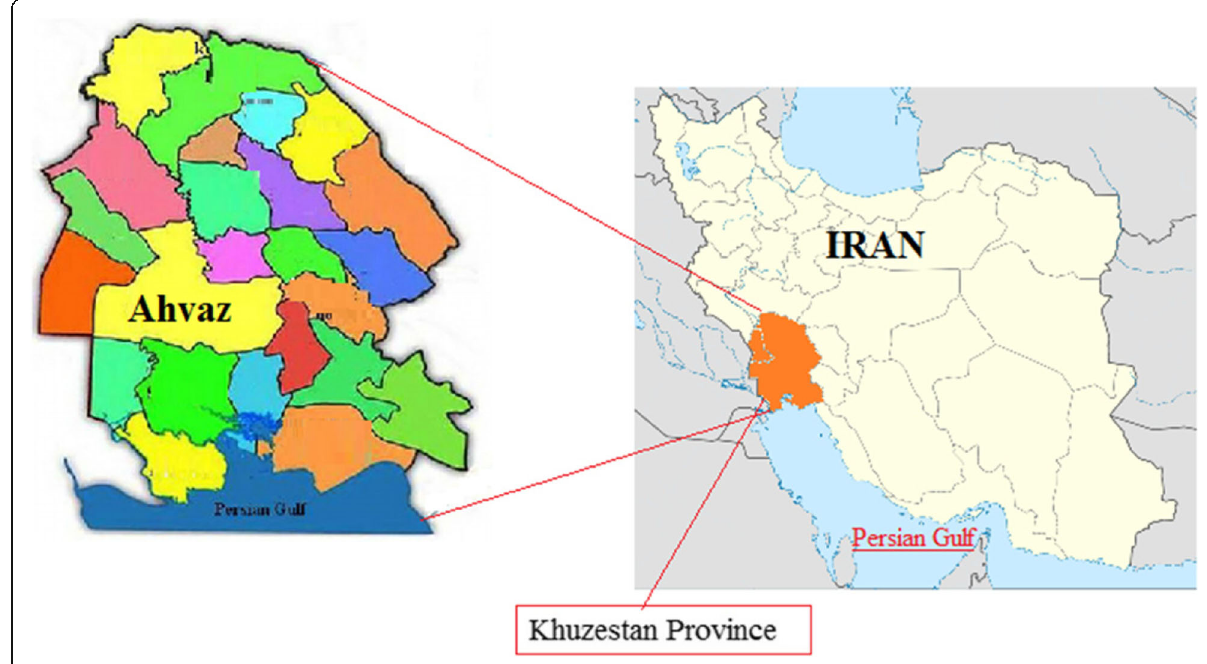
Fig. 1 Map of Khuzestan province, south of